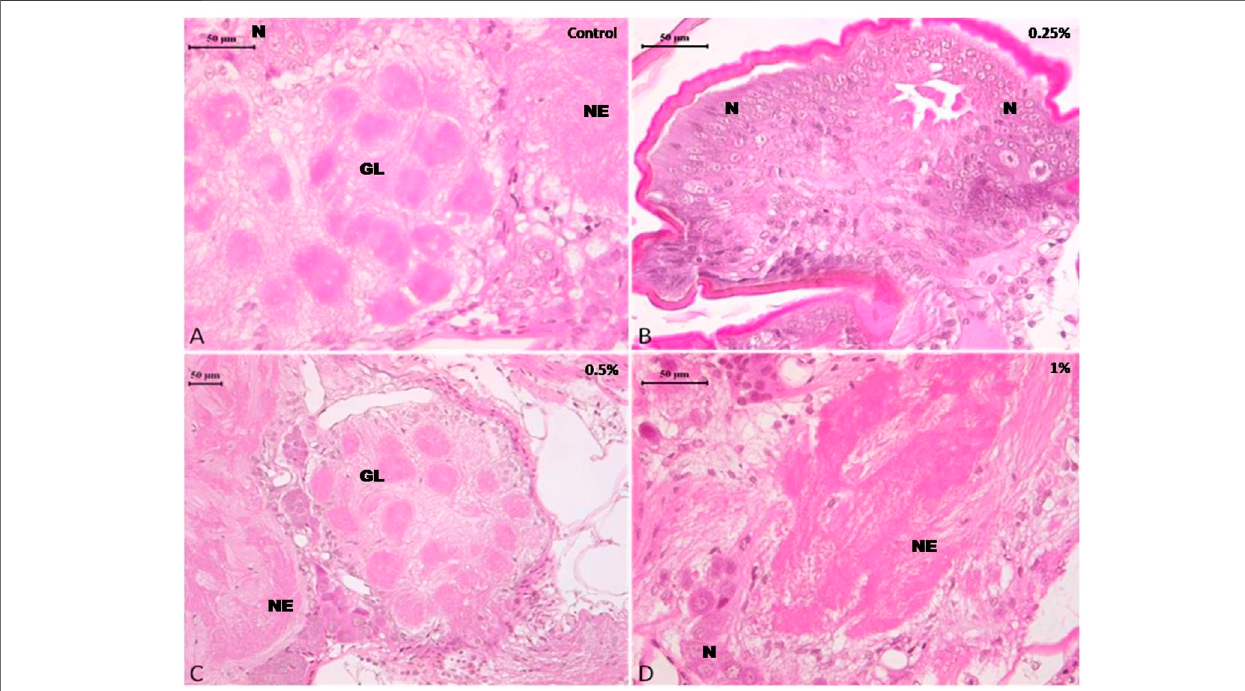
FIGURE2| Photomicrographofcontrolanddeltamethrintreatedcockroach( P.americana )brain: (A) Control; (B) treatedwith0.25%deltamethrin; (C) treatedwith 0.5% deltamethrin; (D) treated with 1% deltamethrin. GL, glomeruli; N, neurons; NE, neuropile.